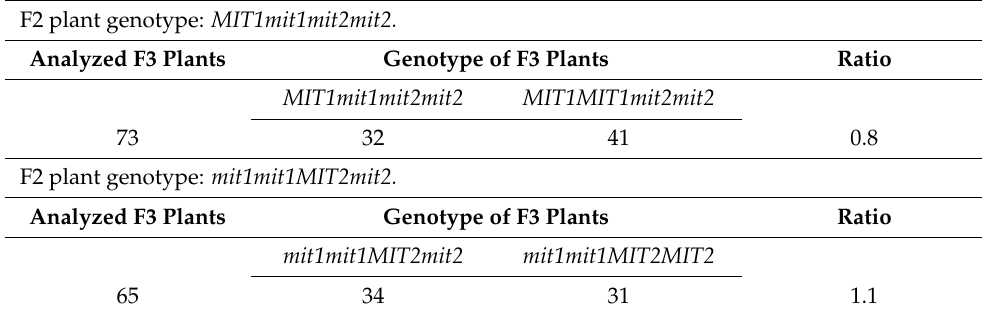
Table 1. Segregation analysis in the progeny of F2 plants carrying three mutated alleles. F2 plant genotype: